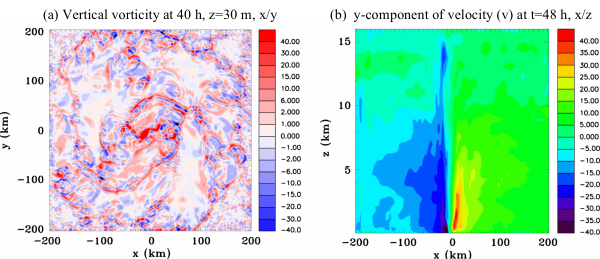
Figure 22. Experiment 13: full physics with radiation in the whole domain. (a) Horizontal section of surface vertical vortic- ity, at t = 40h ( × 10 − 4 rads − 1 ), and (b) vertical section of the y - component of velocity, v , at 48h (ms − 1